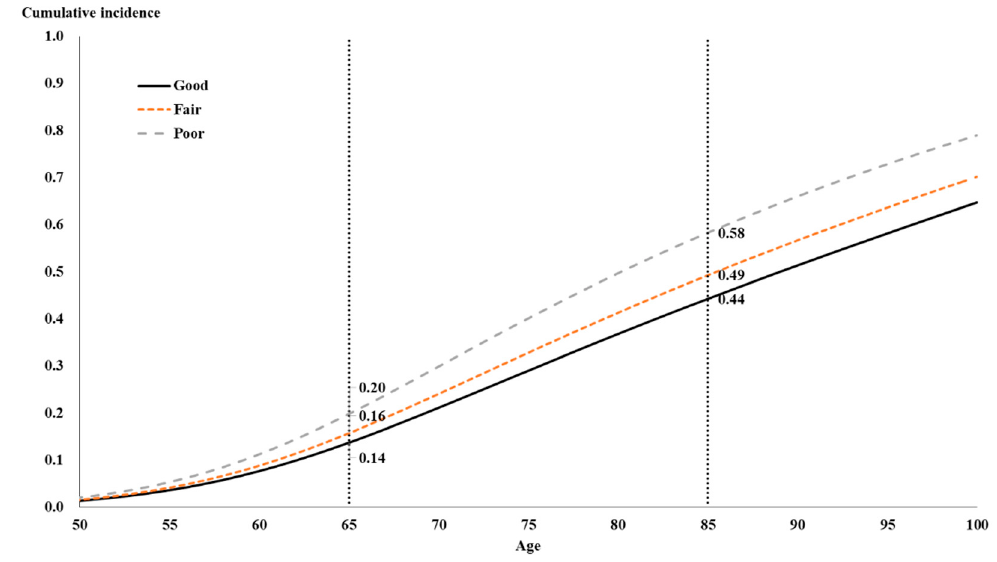
Figure 3. The cumulative incidences of diabetes mellitus by self-rated health.